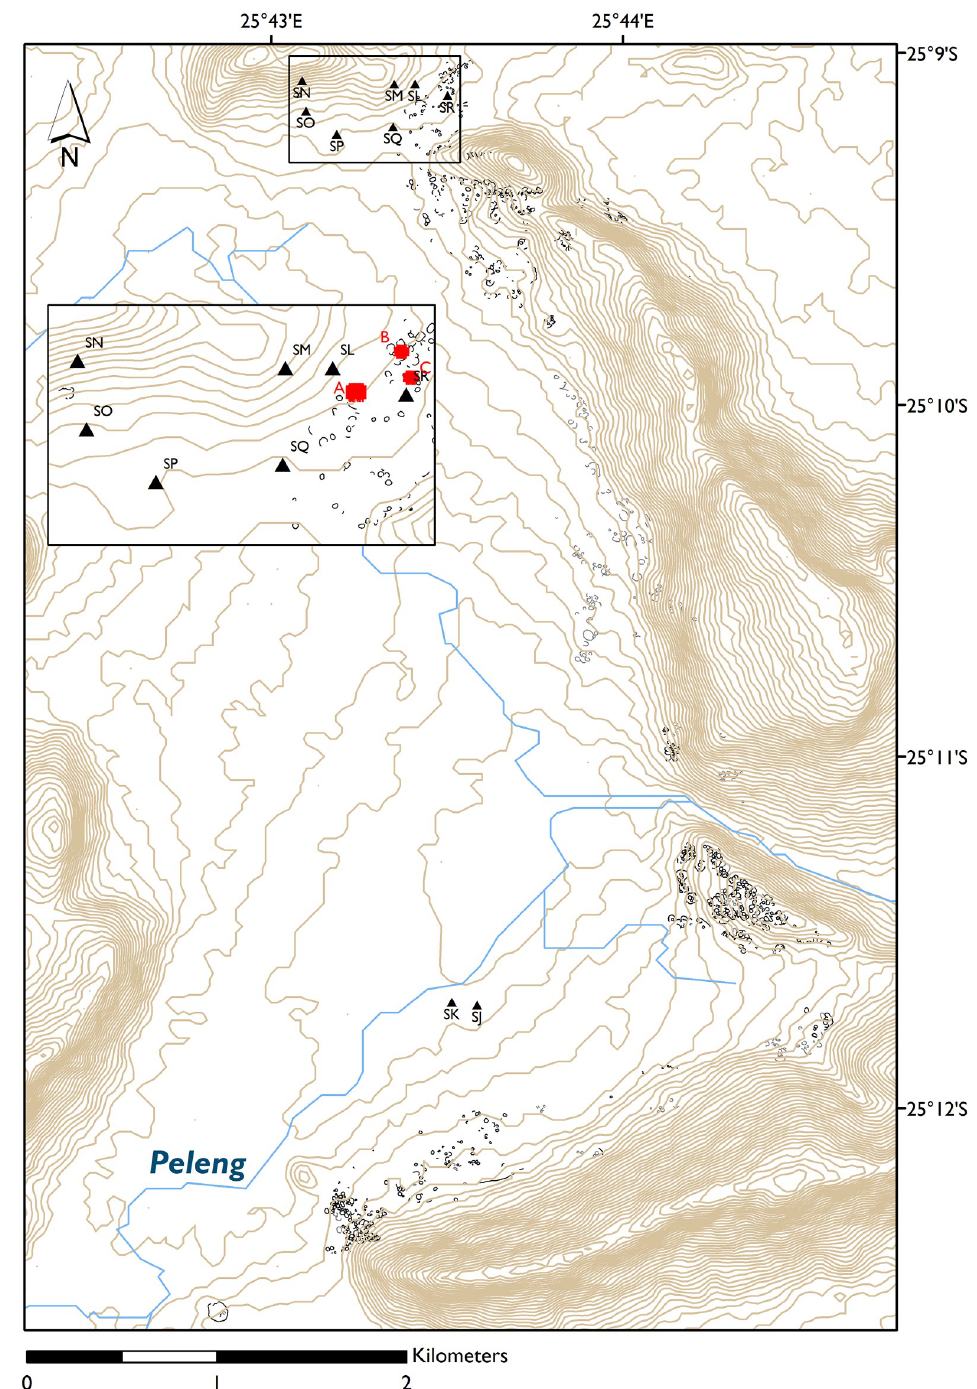
Fig 2. Map of Seoke SWS. Stone walls in black were surveyed on the ground, stone walls in grey were manually digitised by S. Merlo from GoogleEarth imagery and not verified on the ground. The position of the control samples (black triangles) and sampling areas (red squares) are indicated. Sources: contour data and rivers extracted from Aster DEM by S. Merlo.